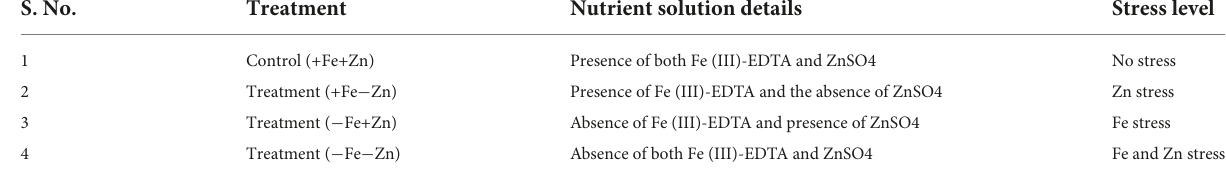
TABLE 1 Details of the nutrient stress treatments given to the seedlings of the pearl millet inbred ICMB 1505. S.